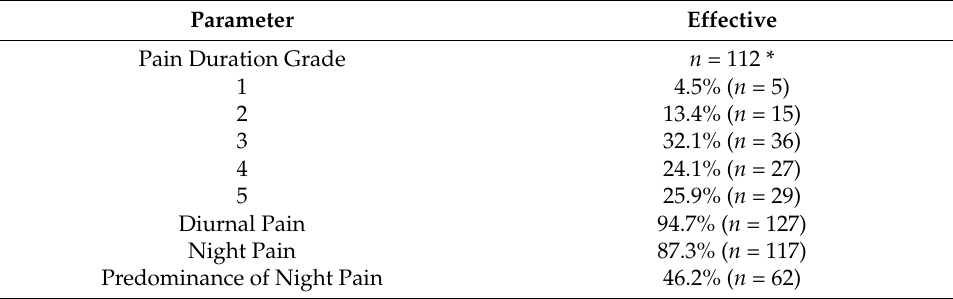
Table 2. Summary of patients’ pain